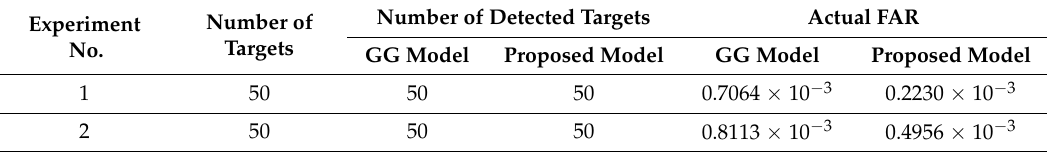
Table 3. Whole Detection Performance Comparison with P fa = 10 − 3 . FAR: false alarm